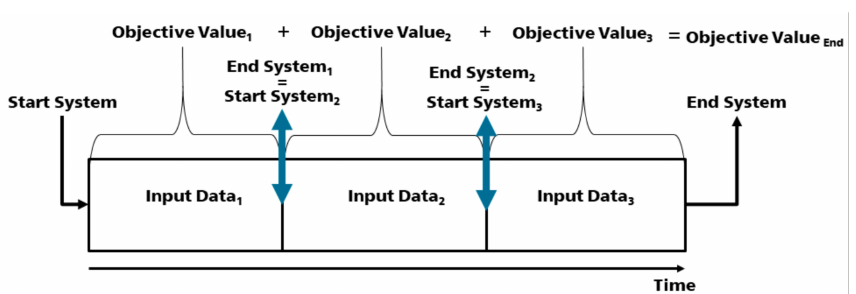
Figure 1. Illustration of the perfect foresight approach.